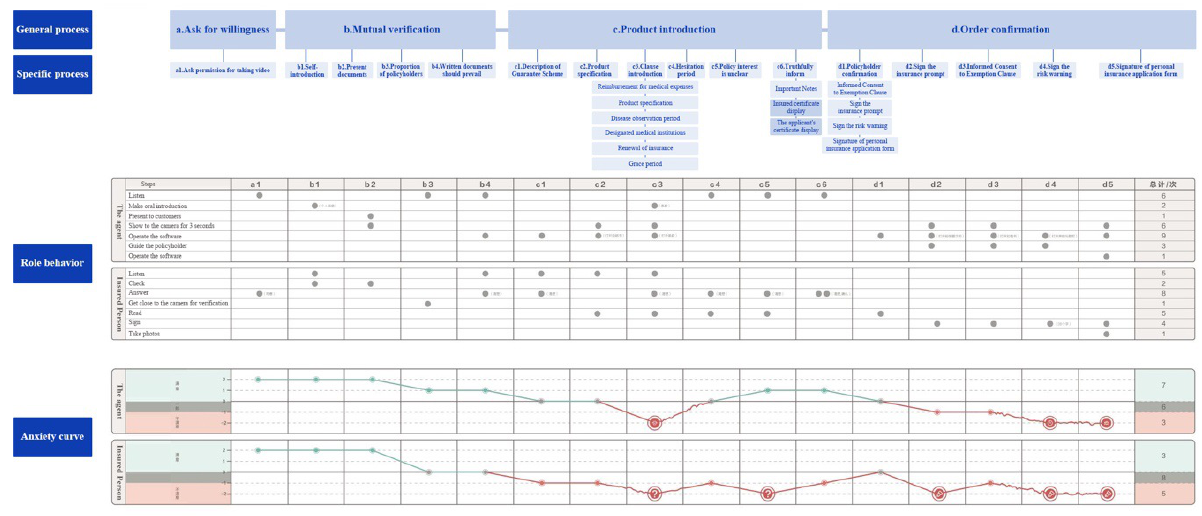
Fig. 2 Process analysis diagram of insurance recording